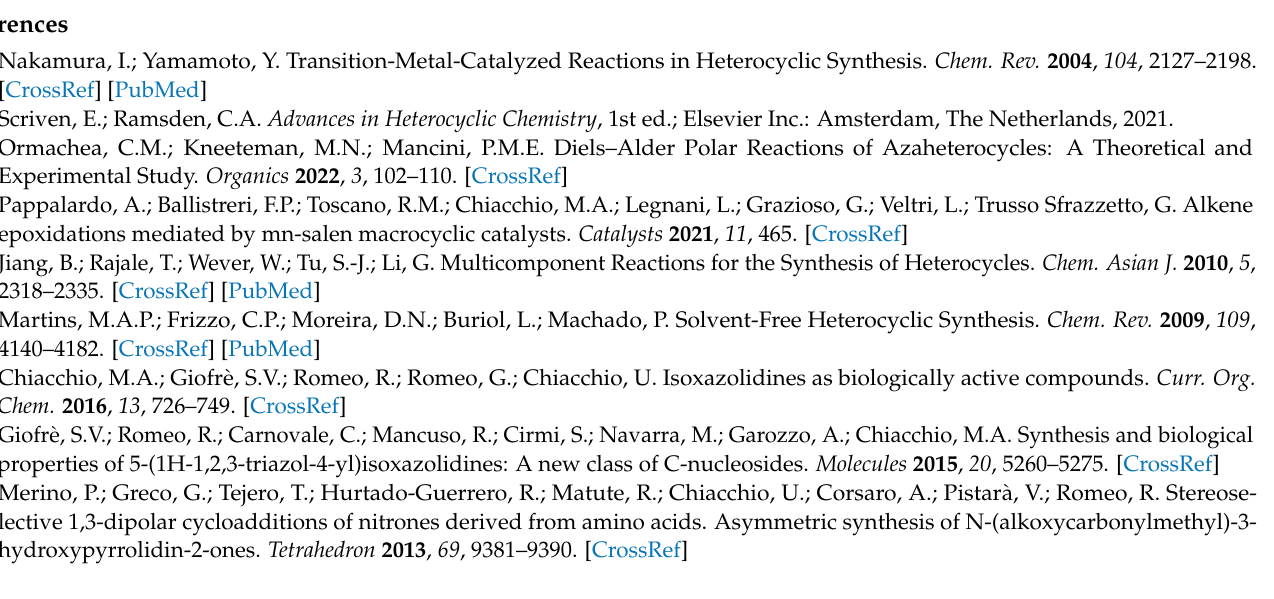
NMR of 2b ; Figure S4: 13 C NMR of 2b ; Figure S5: 1 H NMR of 2c ; Figure S6: 13 C NMR of 2c ; Figure S7: 1 H NMR of 3a ; Figure S8: 13 C NMR of 3a ; Figure S9: 1 H NMR of 3c ; Figure S10: 13 C NMR of 3c ; Figure S11: 1 H NMR of 6 ; Figure S12: 13 C NMR of 6 ; Figure S13: 1 H NMR of 7 ; Figure S14: 13 C NMR of 7 ; Figure S15: NBO analysis of ion pair IP located along the reaction pathway of compounds 1a – c ; B3LYP/def2svp/emp=gd3bj/int=ultrafine/solvent=water cartesian coordinates; Table S1: Free energies and imaginary frequencies for transition states to the oxidation reaction of 1a ; Table S2: Free energies and imaginary frequencies for transition states to the oxidation reaction of 1b ; Table S3: Free energies and imaginary frequencies for transition states to the oxidation reaction of 1b